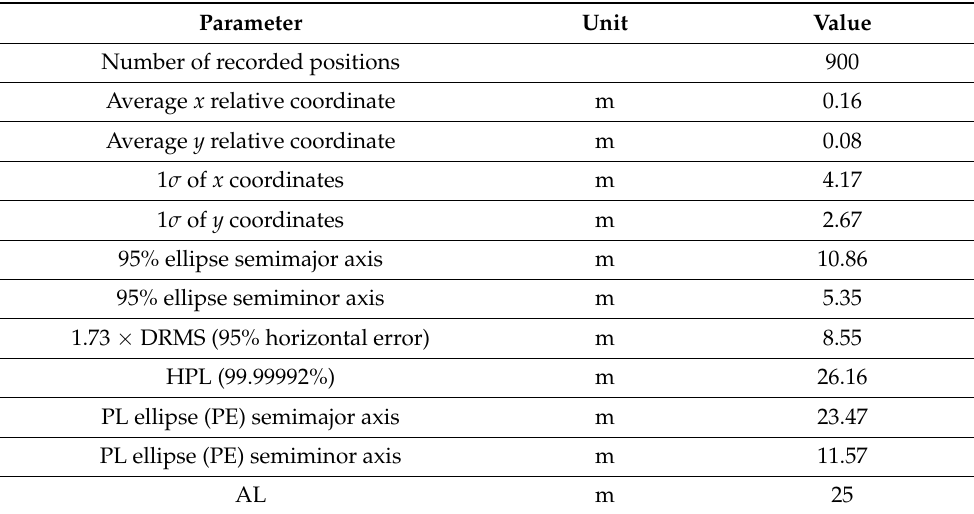
Figure 6. Example of 2D 95% and 99.99992% confidence ellipses, and AL circle for GNSS recorded data (own study). Table 2. Parameters of sample GNSS position data in the Figure 6.